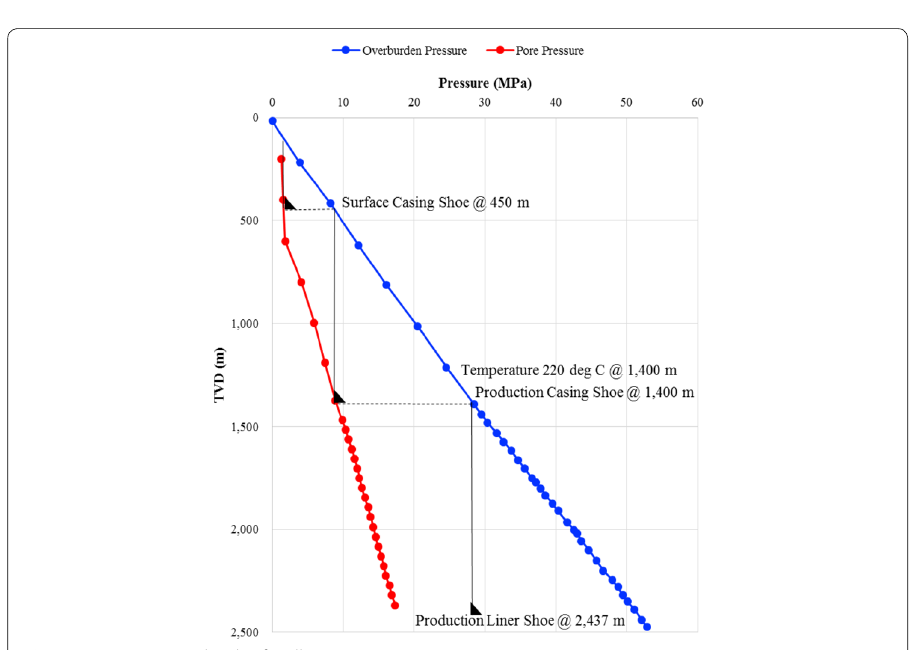
Fig. 6 Casing setting depth of well